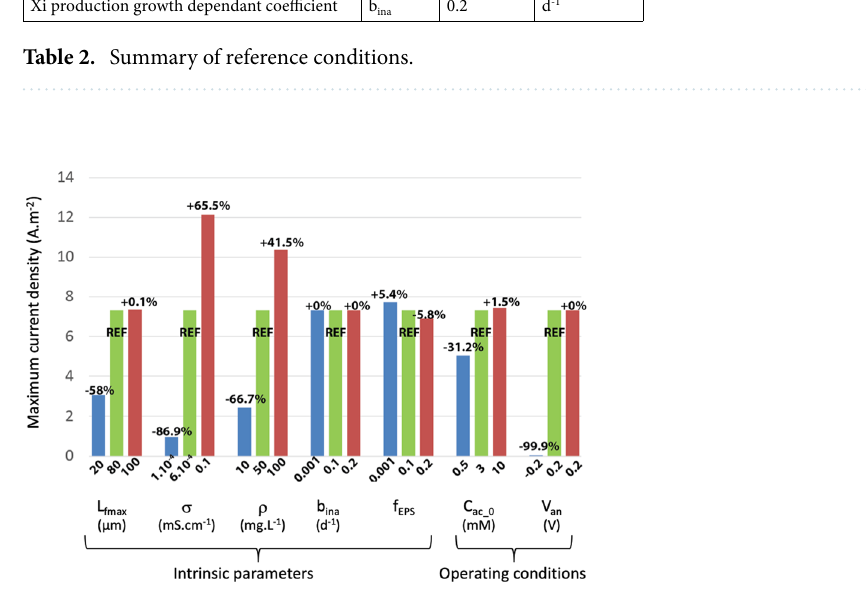
Figure 3. Evolution of maximum current densities with various parameters comparing to reference conditions (Table